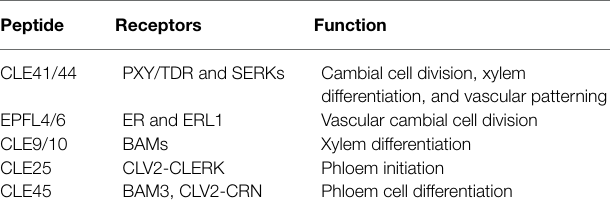
TABLE 1 | CLAVATA3/EMBRYO SURROUNDING REGION-RELATED (CLE) peptides and their receptors in regulating vascular development.